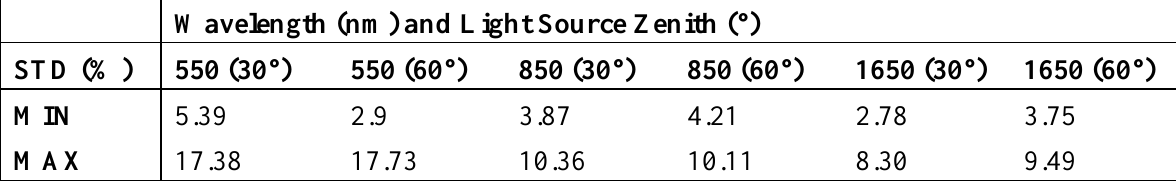
Table 4 . Minimum and maximum standard deviation in percentage among the 12 leaves measured for two BRF angular positions. Namely for the light source at 30° zenith and 0° azimuth and for the light source at 60° zenith and 0° azimuth. Values for three wavelengths are